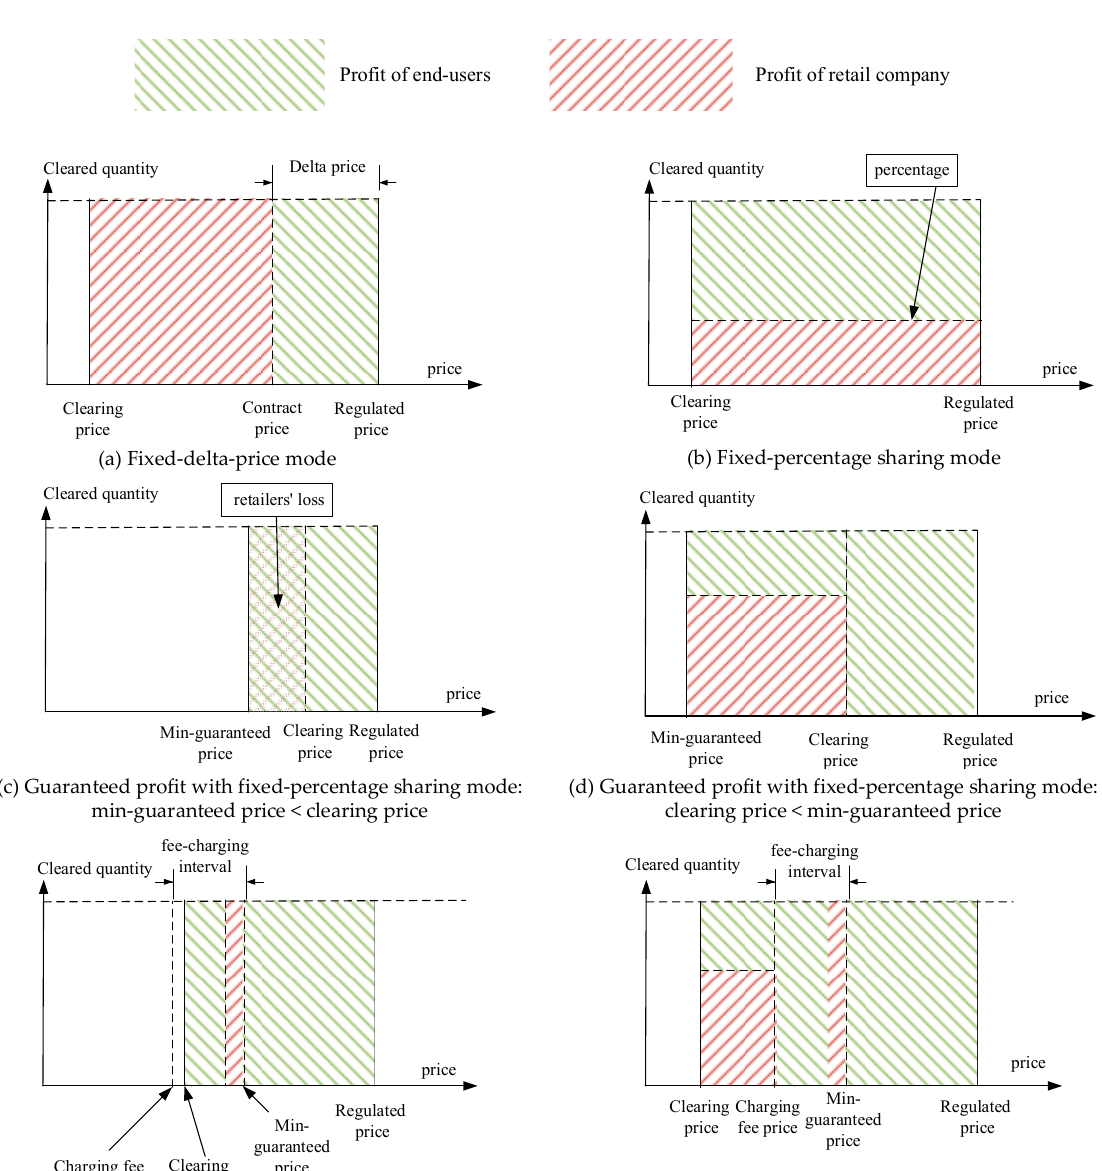
Figure 4. Illustrative figures of profit-sharing modes.